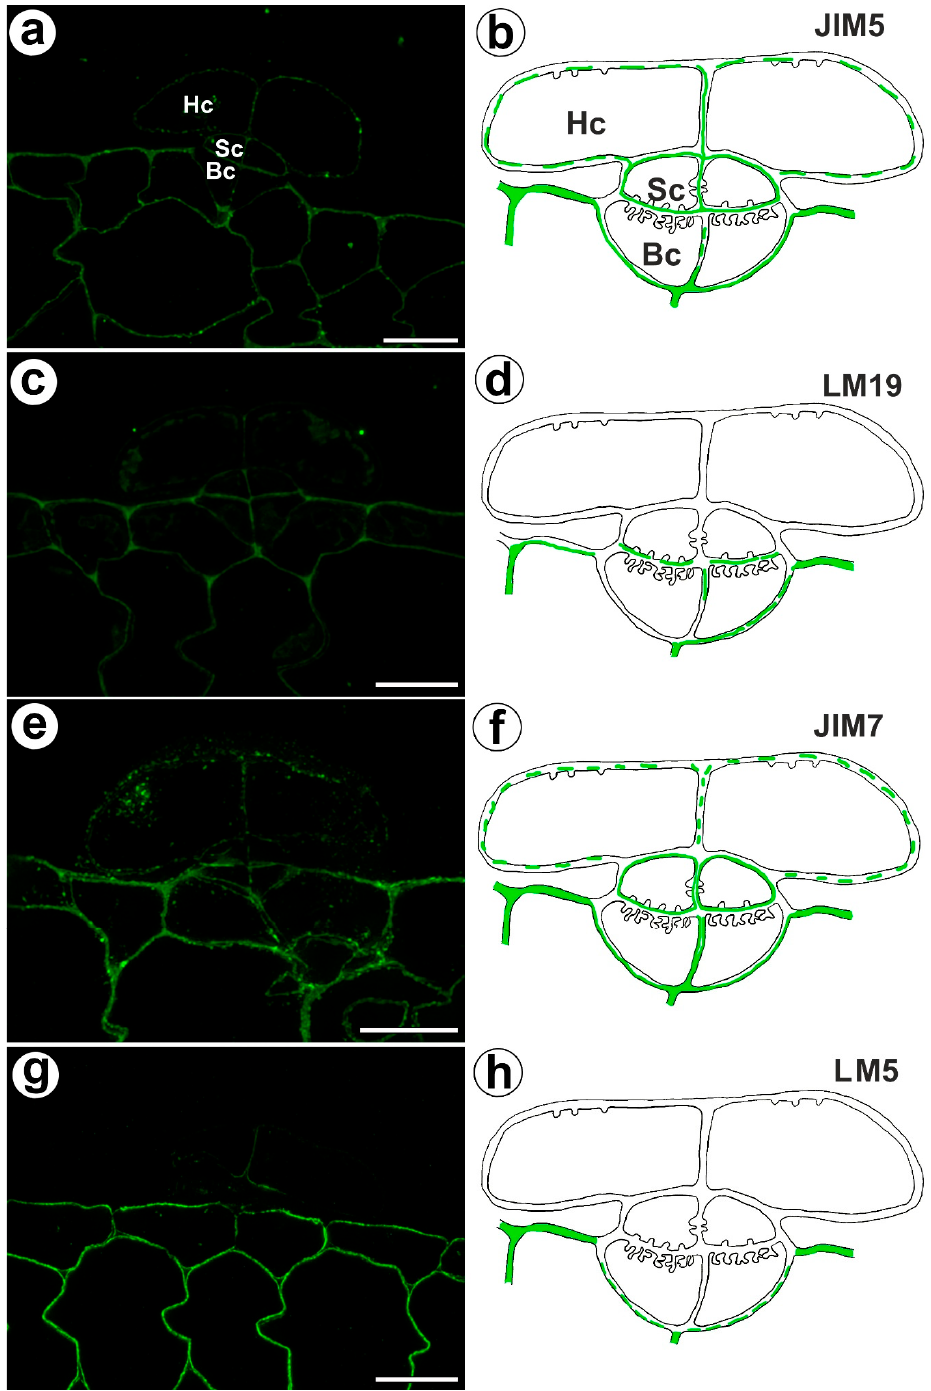
Figure 4. Homogalacturonan detected in the bifid trichomes of the Aldrovanda vesiculosa traps. ( a ) HG (labeled with JIM5) that was detected in a trichome, head cell (Hc), stalk cell (Sc), basal cell (Bc), bar 10 µm. ( b ) Schematic occurrence (green) of the HG (labeled with JIM5) detected in a trichome, head cell (Hc), stalk cell (Sc), basal cell (Bc). ( c ) HG (labeled with LM19) detected in a trichome, bar 10 µm. ( d ) Schematic occurrence (green) of the HG (labeled with LM19) detected in a trichome. ( e ) HG (labeled with JIM7) detected in a trichome, bar 10 µm. ( f ) Schematic occurrence (green) of the HG (labeled with JIM7) found in a young trichome. ( g ) HG (labeled with LM5) detected in a trichome, bar 10 µ m. ( h ) Schematic occurrence (green) of the HG (labeled with LM5) detected in a